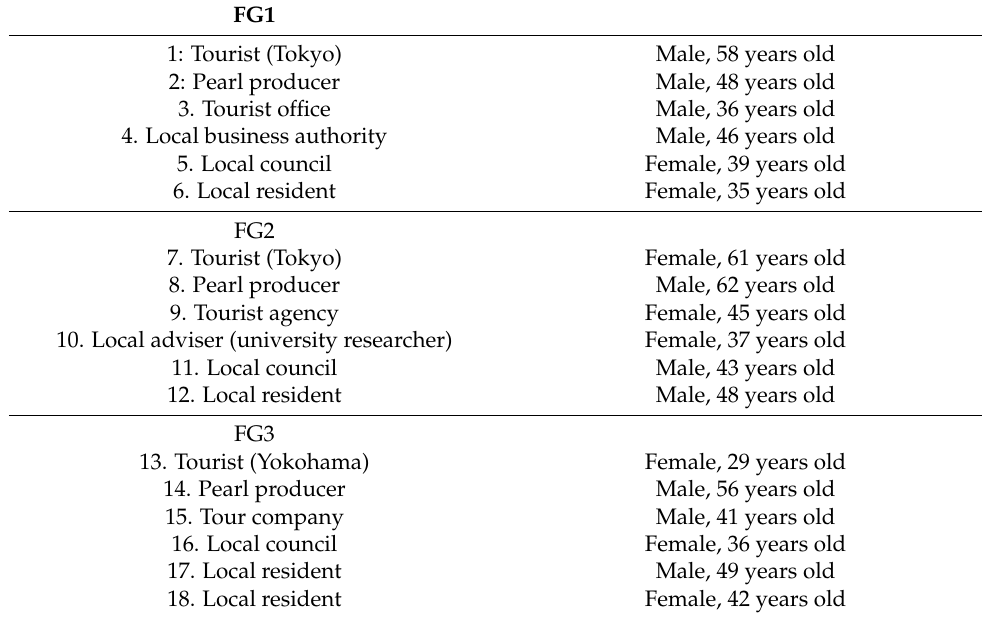
Table 2. Profile of the